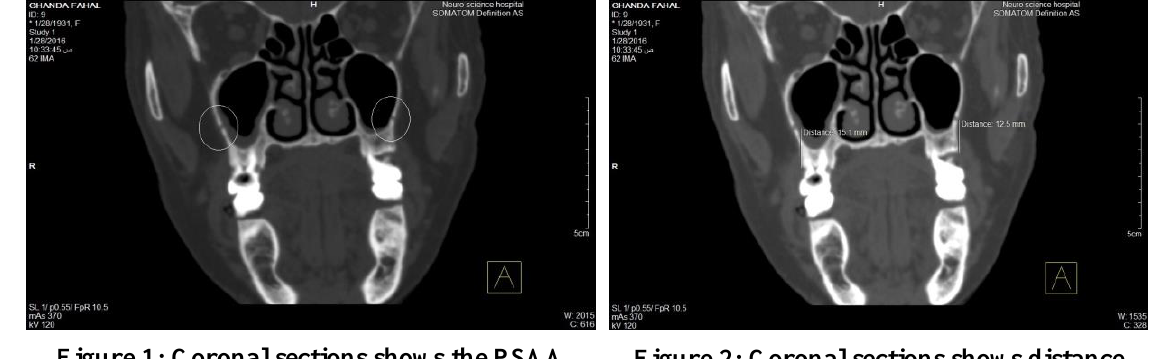
Figure 1: Coronal sections shows the PSAA canal